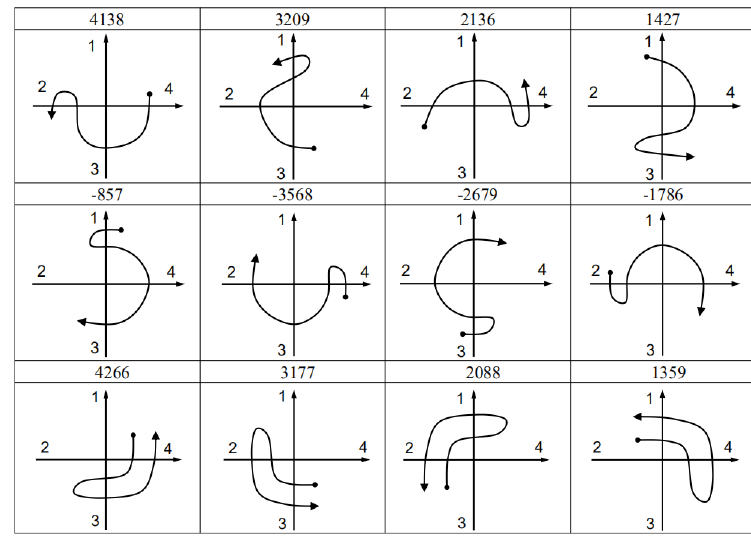
Figure A4. Code templates and sketch maps of right gesture.